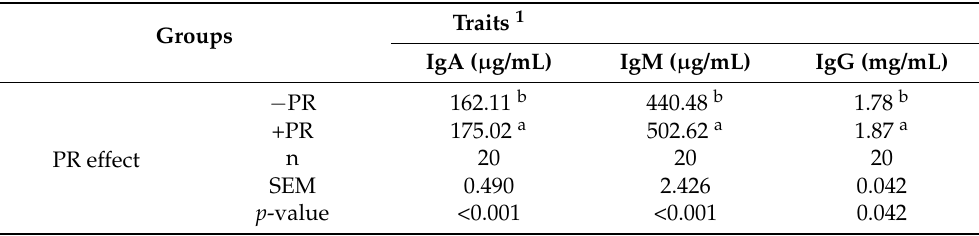
Table 7. Effect of propolis (PR), bee pollen (BP), and their interaction (PR + BP) on immunoglobulins of broiler